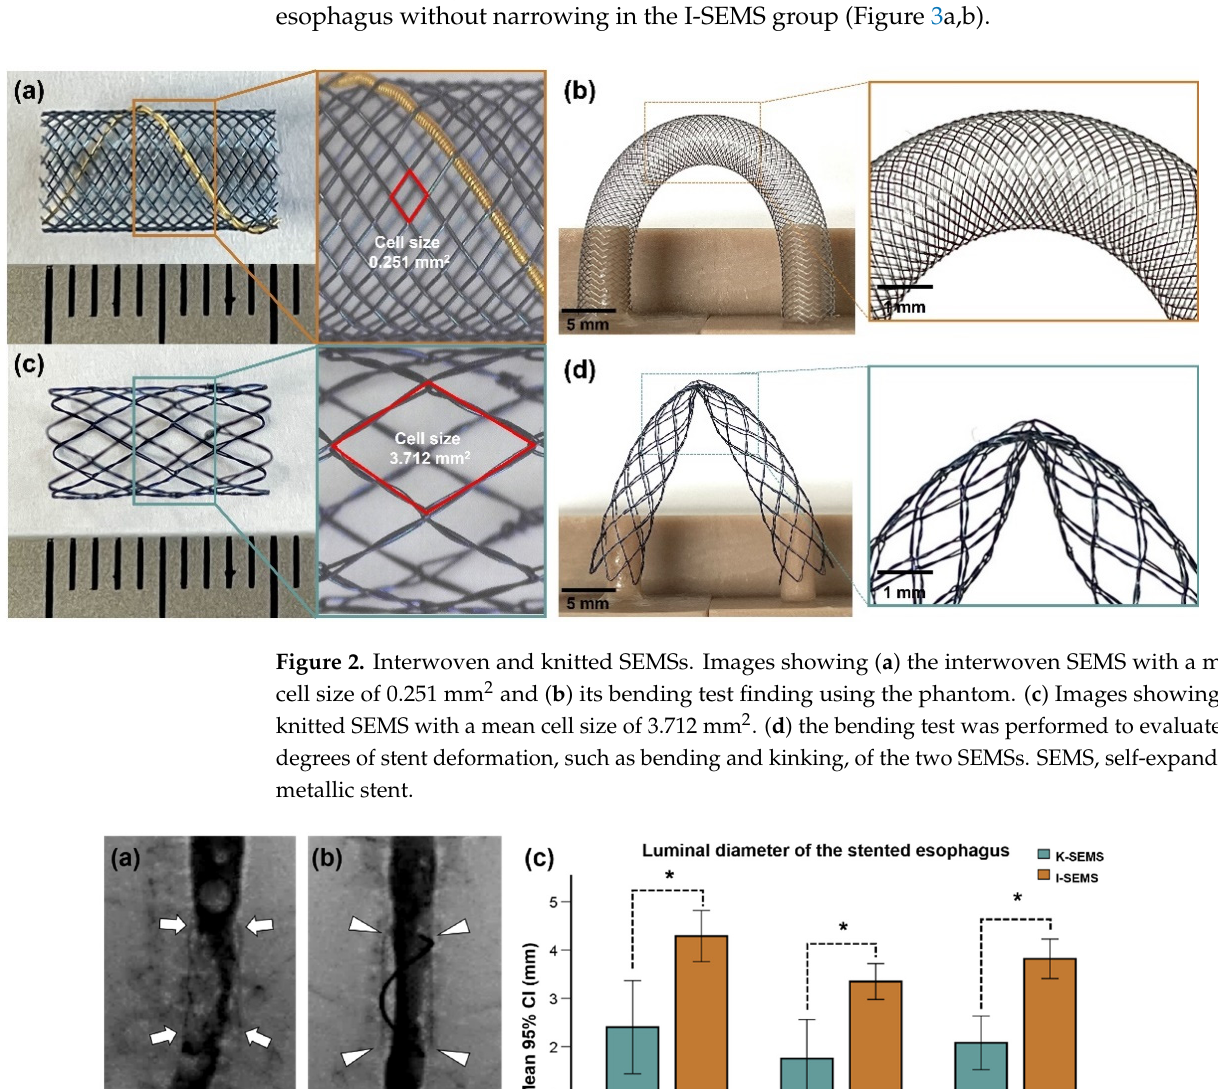
Figure 2. Interwoven and knitted SEMSs. Images showing ( a ) the interwoven SEMS with a mean cell size of 0.251 mm 2 and ( b ) its bending test finding using the phantom. ( c ) Images showing the knitted SEMS with a mean cell size of 3.712 mm 2 . ( d ) the bending test was performed to evaluate the degrees of stent deformation, such as bending and kinking, of the two SEMSs. SEMS, self-ex- pandable metallic stent.